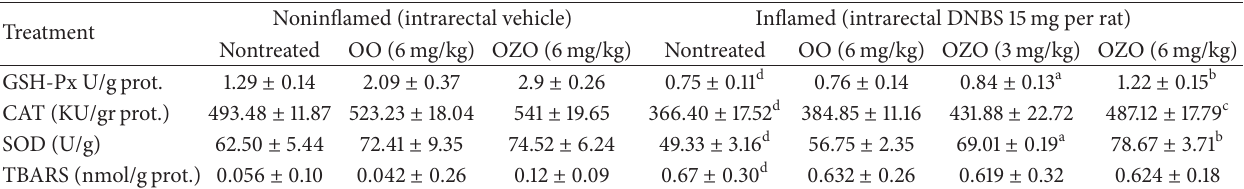
Table 3: Effects of OO and OZO in noninflamed and inflamed rats.